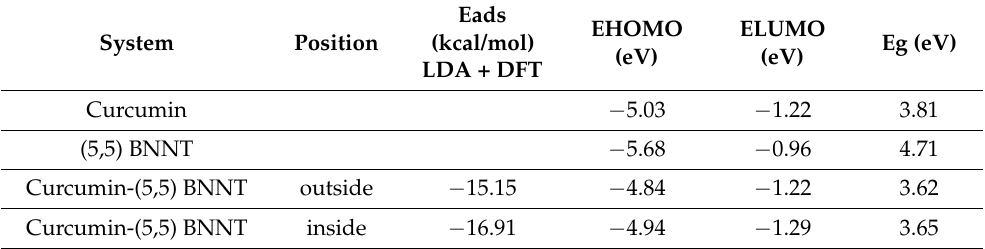
Table 4. The adsorption energies and the geometric parameters of curcumin drug adsorbed on the BNNTs. System Position